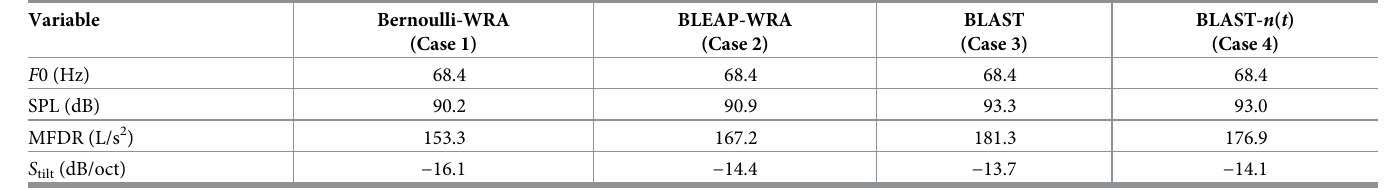
Table 3. Impact of Bernoulli-WRA (Case 1), BLEAP-WRA (Case 2), BLAST(Case 3), and BLAST- n ( t ) (Case 4), and their effect on fundamental frequency ( F 0), sound pressure level (SPL), maximum flow declination rate (MFDR) and spectral tilt ( S tilt ) for p s = 0.65 kPa and Z = 0.5.